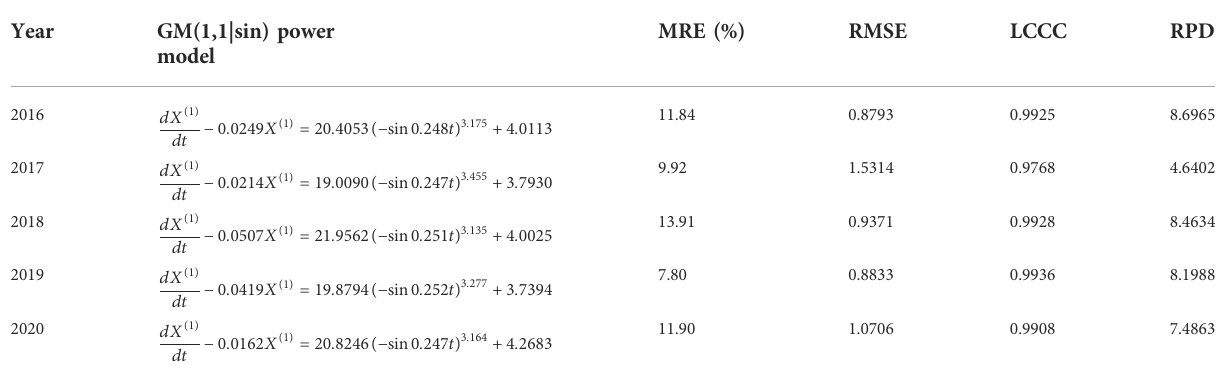
TABLE 11 Adjusted prediction models in 5